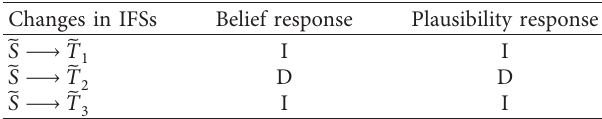
Table 1: Belief and plausibility responses on variations in IFSs. Changes in